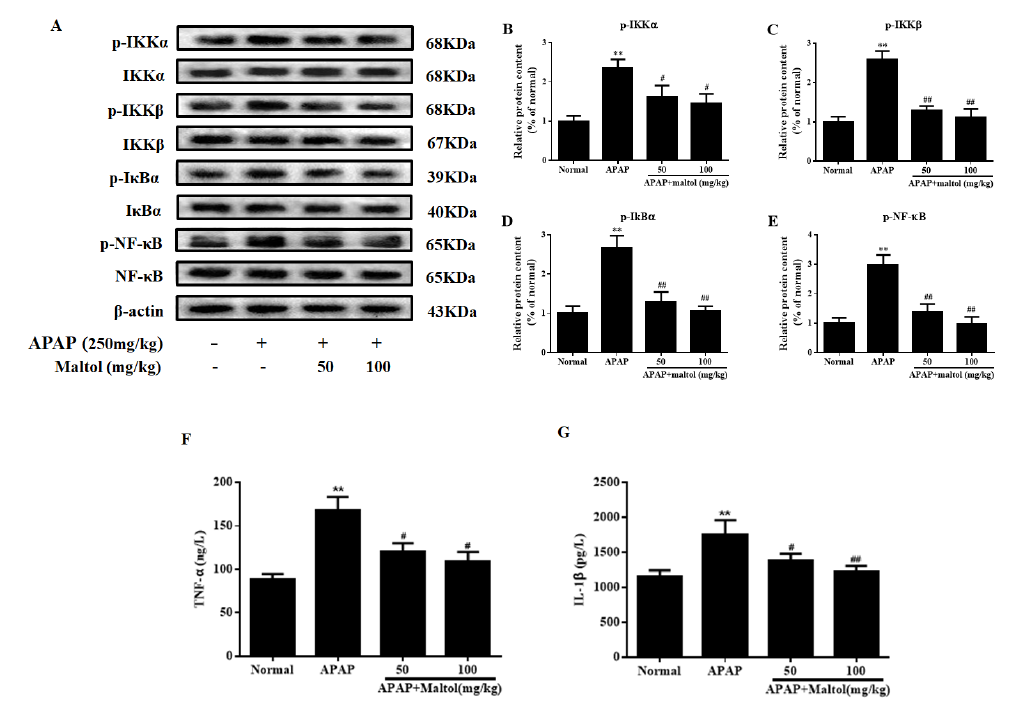
Figure 6. Effects of maltol pretreatment on APAP-induced activation of the nuclear factor-kappa B (NF- κ B) signaling pathway in ALI mice. ( A ) Protein expression of phosphorylated and total inhibitor kappa B kinase α/β (IKKα/β), NF-kappa-B inhibitor alpha (IκBα) and NF-κB were measured by western blotting, and β-actin protein was used as a loading control. ( B – E ) The relative protein expression levels were quantified by densitometric analysis. The levels of ( F ) tumor necrosis factor α (TNF-α) and ( G ) interleukin-1β (IL-1β) in the serum of mice. Data are expressed as mean ± S.D., n = 8 ; ** p < 0.01 vs normal group; ## p < 0.01 , # p < 0.05 vs APAP group.